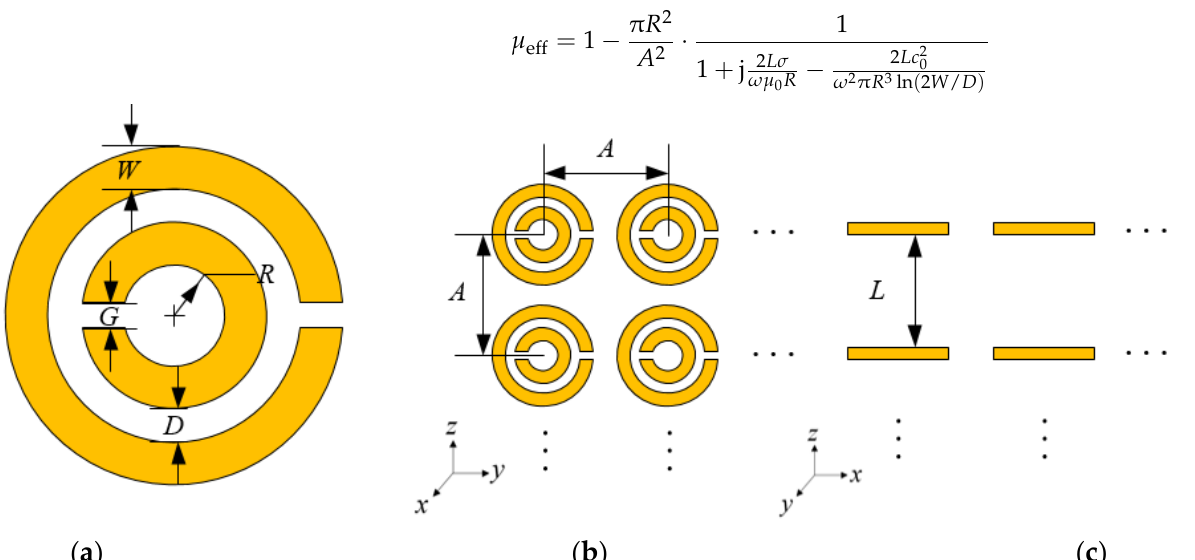
Figure 2. The SRR array: ( a ) the SRR unit; ( b ) the top view; ( c ) the side view.